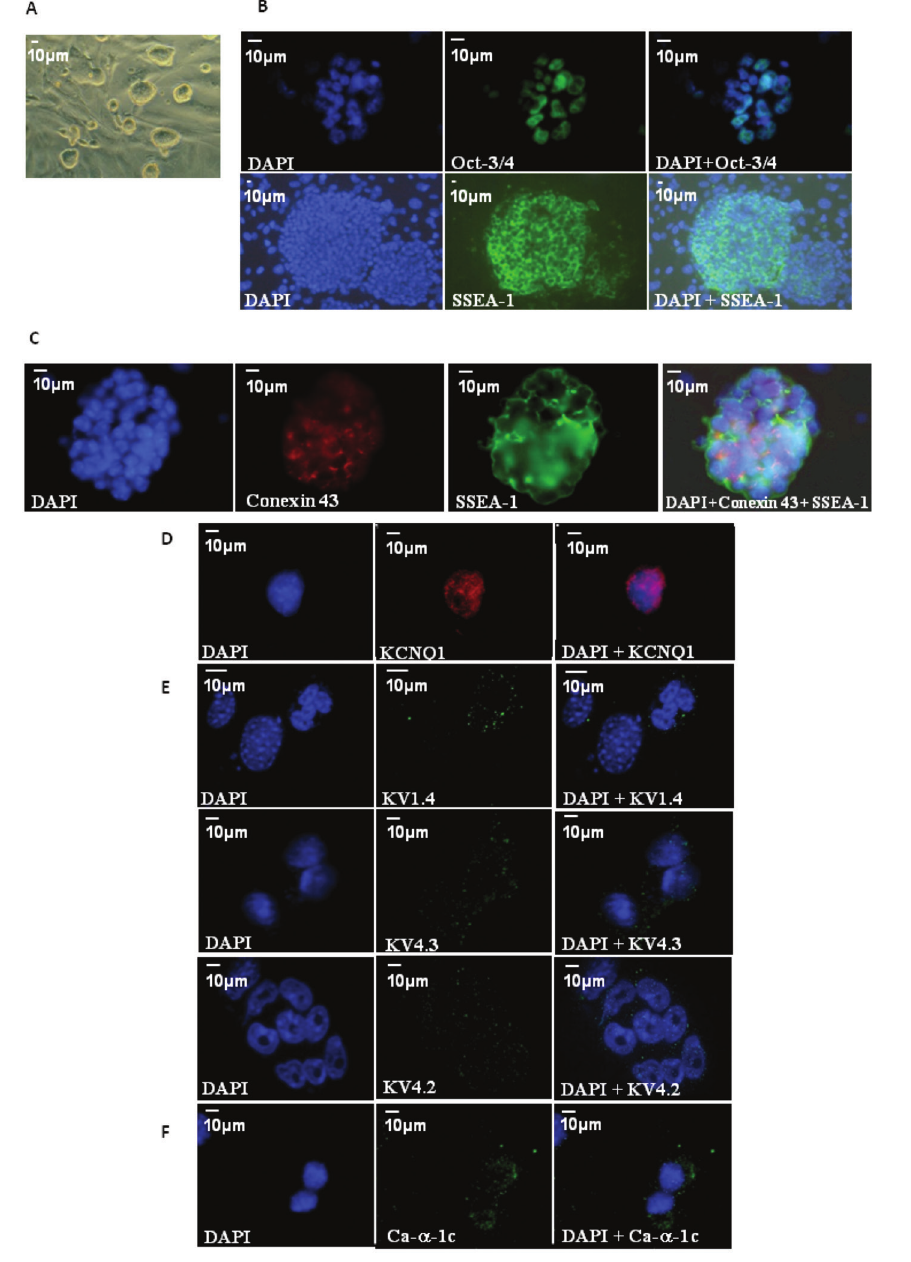
Figure 2 - Morphology of cell culture and localization of molecules. A: Morphology of undifferentiated mESC in phase contrast (original magnification 320X); B: Immunofluorescence of pluripotency markers protein. Top line, DAPI (left), Oct-3/4 (middle) and merge images (right) (original magnification 630X). Line below, DAPI (left), Oct-3/4 (middle) and merge images (right) (original magnification 200X); C: immunofluorescence against Cx43 and surface protein SSEA -1 in undifferentiated mESC. Nuclei stained with DAPI (left), Gap junction protein Connexin43 and SSEA -1 (middle) and merge of C images (right) (original magnification 630X); D: immunofluorescence of α sub-unit of IKs ion current channel: DAPI (left), KCNQ1 (middle) and merge images (right)(original magnification 1000X); E: shows three α sub-units of I ion current channel, Kv 1.4, Kv 4.3 and Kv to 4.2. DAPI (left), α sub-units (midle) and merged images (right) (original magnification 630X). Finally, (F) α sub-unit of L-type Calcium ion current channel was detected, DAPI (left), Ca- α -1c (middle) and merge images (right) (original magnification